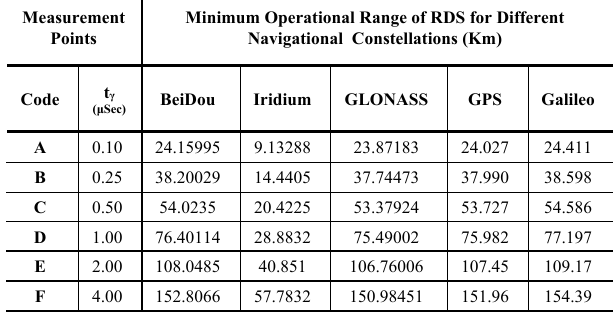
Tab. 2. The calculated minimum operational range of RDS at marked values of its inherent delay as shown in Figure.